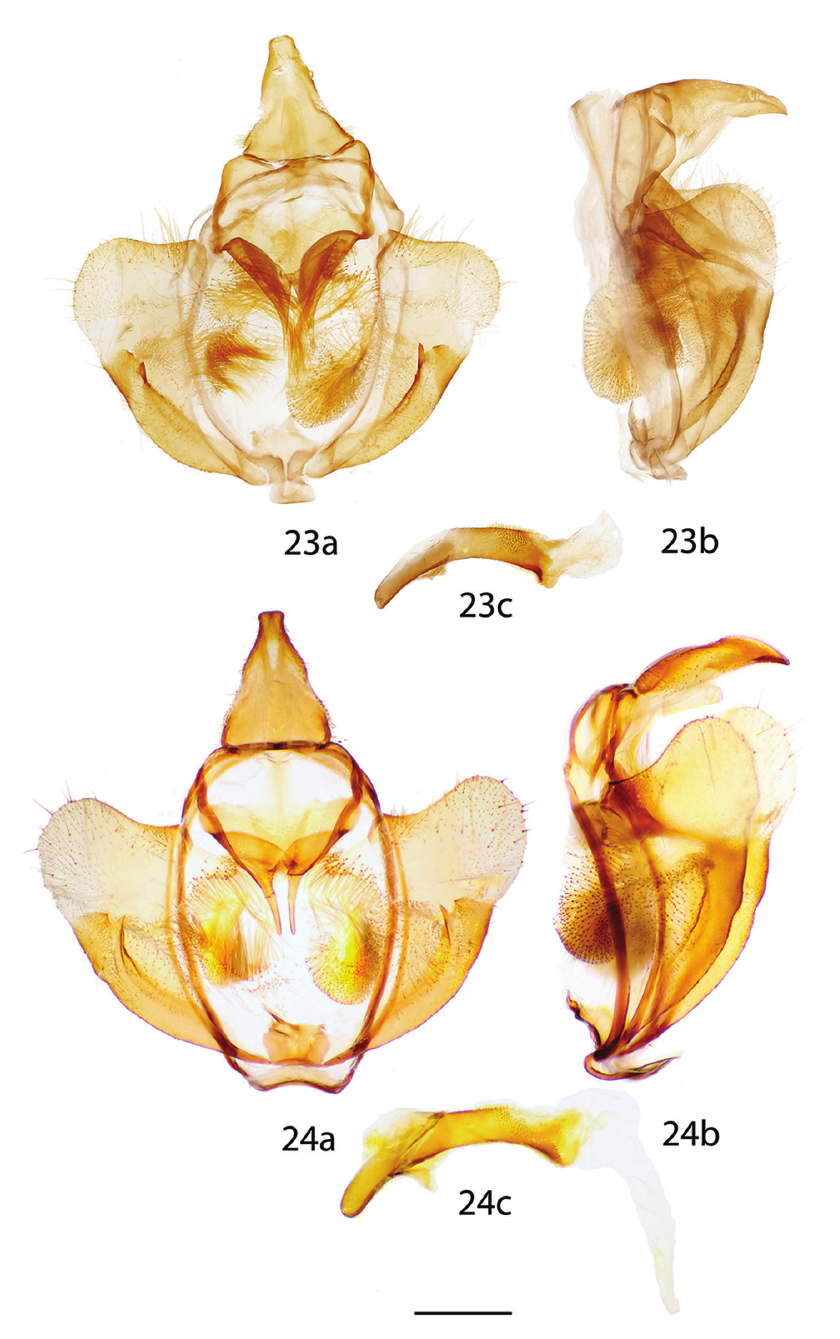
Figures 23, 24. Reinmara male genitalia, a ventral b lateral c phallus lateral. 23 R. enthona , Suriname, Moengo, Boven Cottica River, St Laurent diss.: 10-25-15:2 (CUIC). 24 R. atlantica Holotype, Brazil, Espírito Santo, Linhares, 40 m, St Laurent diss.: 11-1-16:6 (DZUP). Scale bar: 1